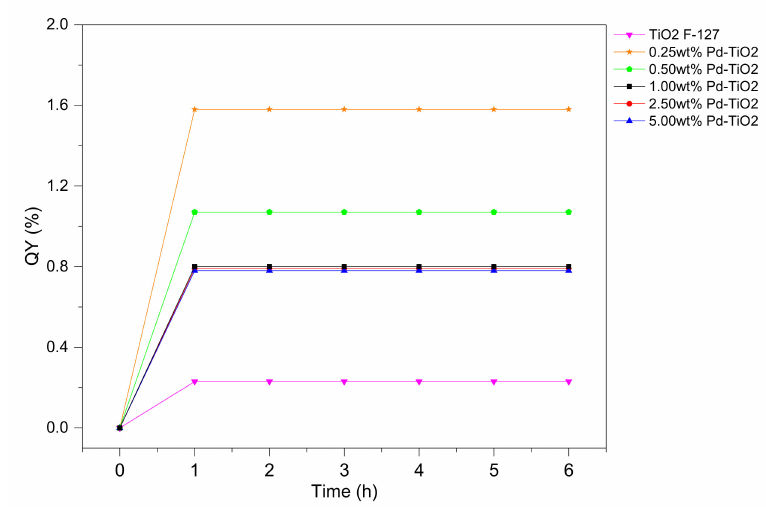
Figure 12. QY% at Various Irradiation Times, under Visible Light, using a 0.15 g / L of Photocatalyst Concentration. Notes: ( a ) Pd on TiO 2 photocatalyst with palladium loadings: 0.25, 0.5, 1.0, 2.5 and 5.0 wt%) and ( b ) Photocatalysts photoreduced using Near-UV irradiation for 1